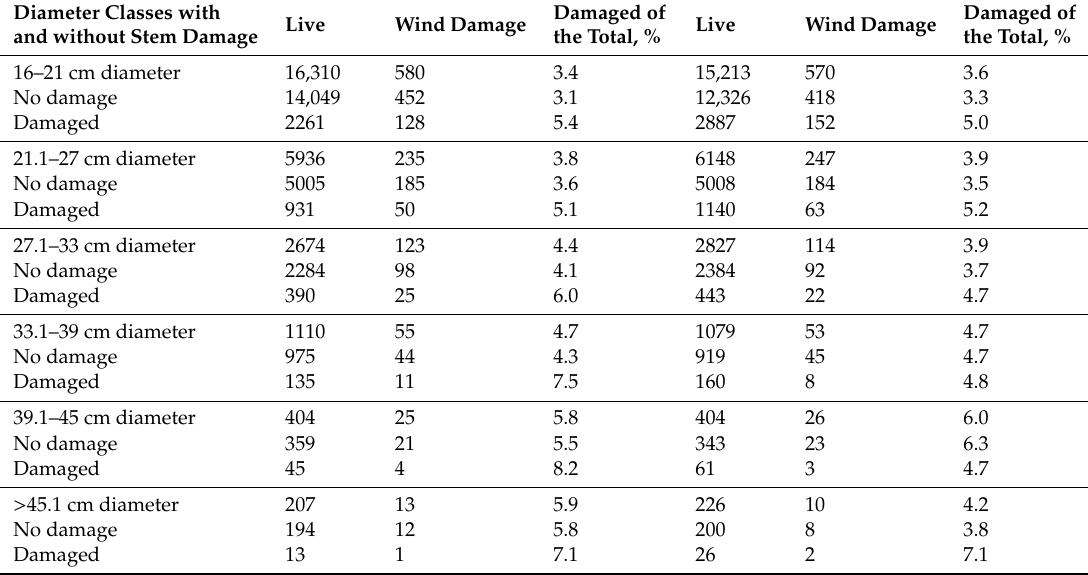
Table 2. Summary of wind-damaged trees based on stem damage and diameter class in two re-measurement